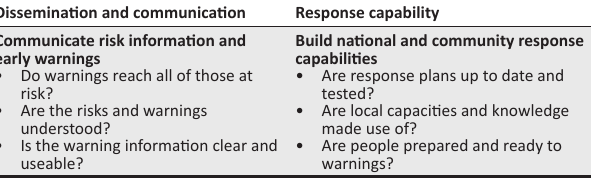
TABLE 2b: Four elements for developing a community-based early warning system. Dissemination and communication